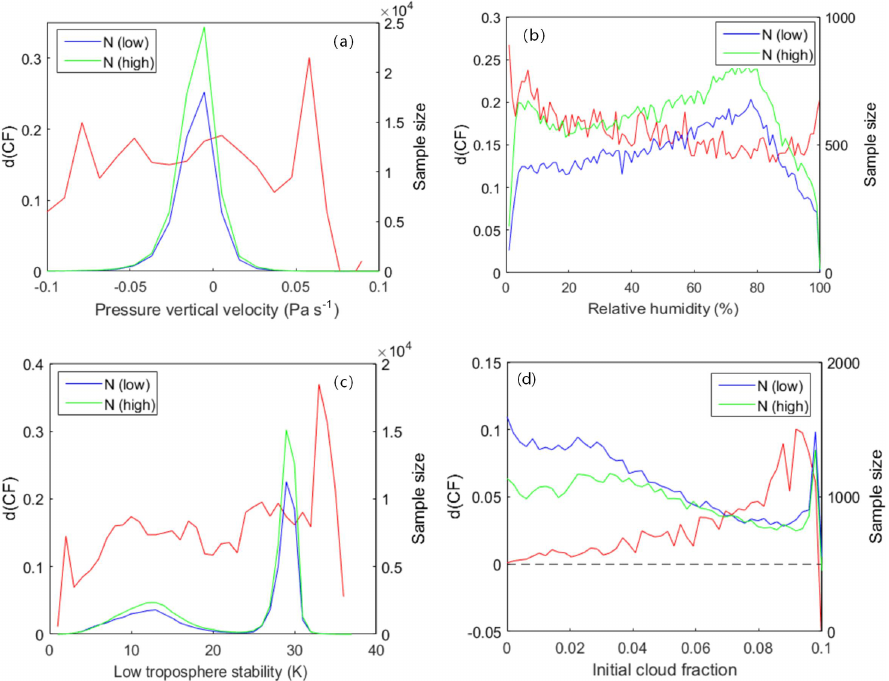
Figure 9. The same as Fig. 8 but for warm clouds when the cloud cover decreases under both low- and high-AOD conditions over land after the 3h time